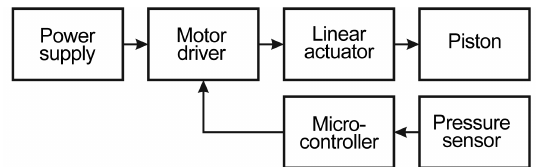
Figure 5. Components of the buoyancy control unit of sensor par-